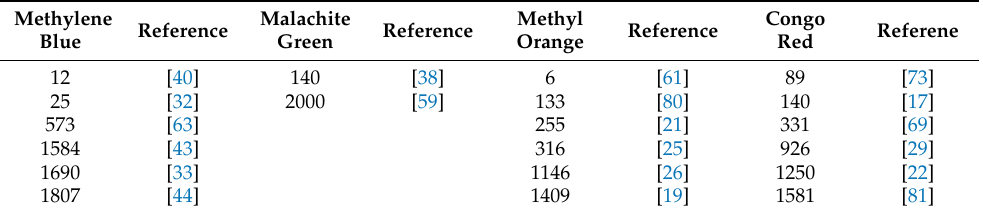
Table 9. Some quantitative results concerning the organic dyes’ uptake onto different adsorbents.